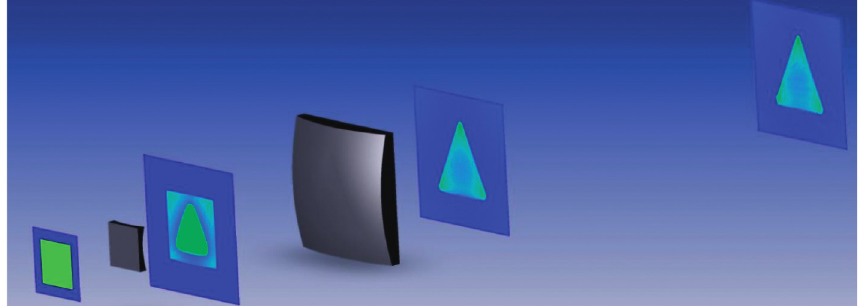
Figure 5: Screenshot from OpticStudio experiment.